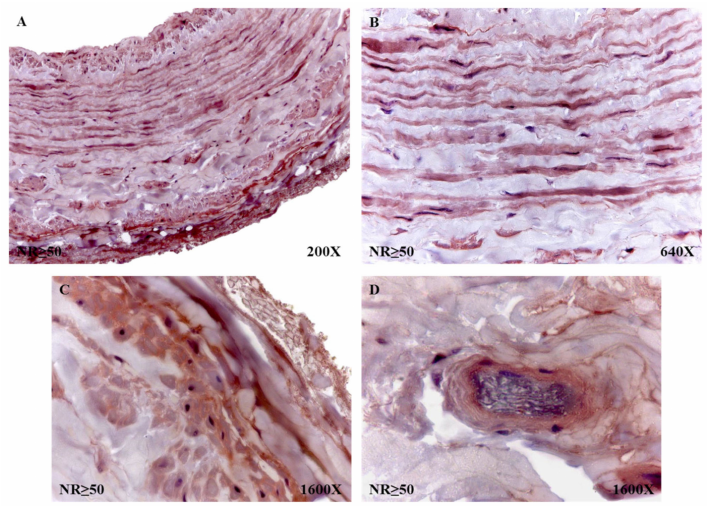
Figure 10. Fibulin 4 protein expression in patients without reflux older than or equal to 50 years (NR ≥ 50). Fibulin 4 expression is shown in all three tunics ( A ), smooth muscle fibers ( B ), detail of elastic fibers ( C ) and blood capillary ( D